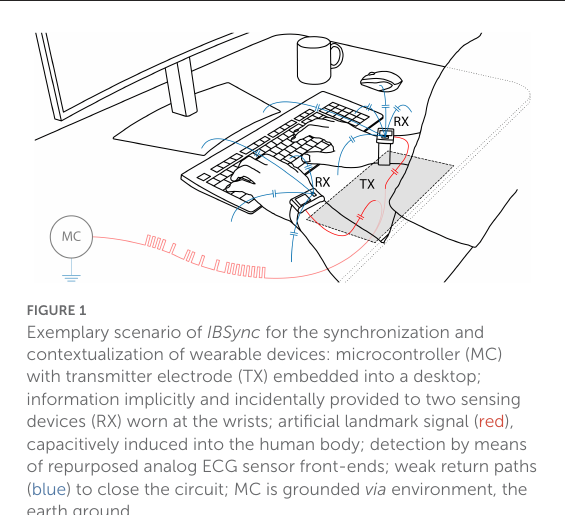
FIGURE1 Exemplary scenario of IBSync for the synchronization and contextualization of wearable devices: microcontroller (MC) with transmitter electrode (TX) embedded into a desktop; information implicitly and incidentally provided to two sensing devices (RX) worn at the wrists; artificial landmark signal (red), capacitively induced into the human body; detection by means of repurposed analog ECG sensor front-ends; weak return paths (blue) to close the circuit; MC is grounded via environment, the earth